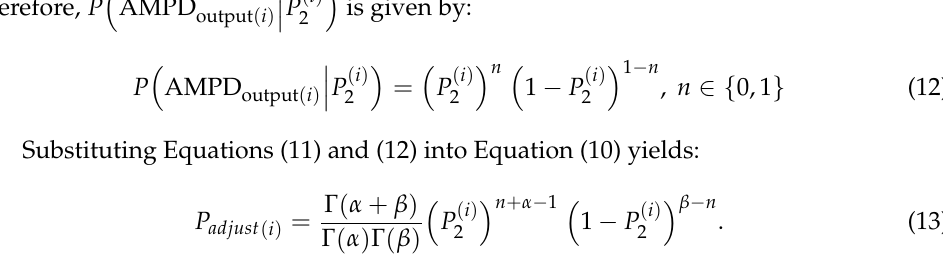
Figure 6. PDF of posterior ( n = 1) and PDF of posterior ( n = 0).